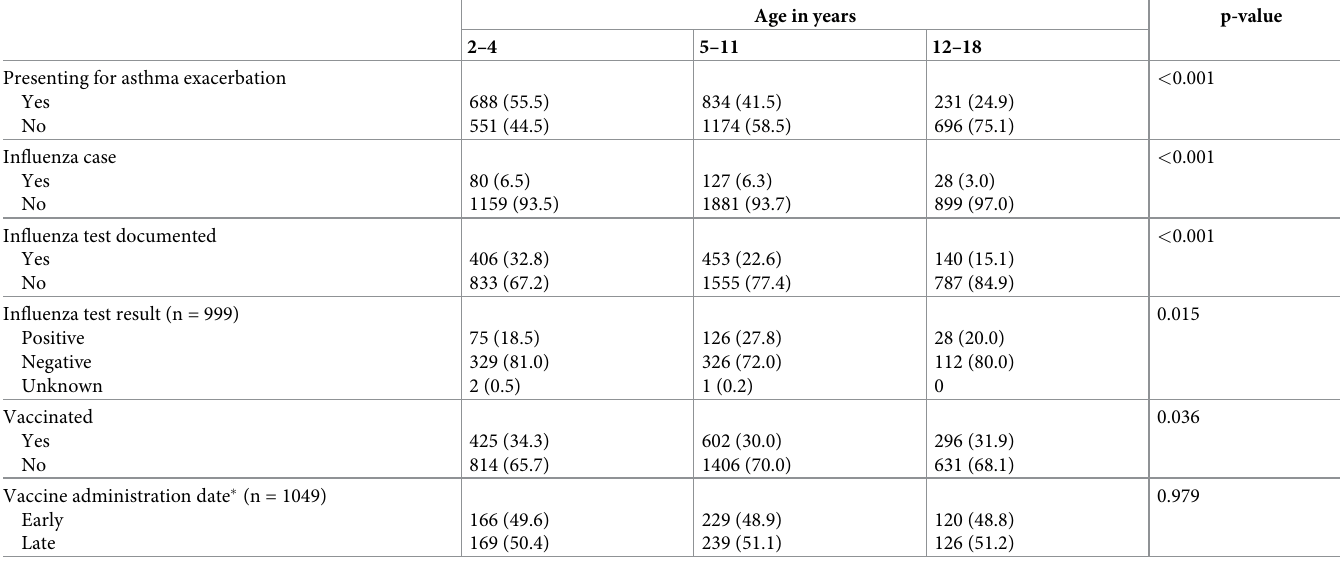
Table 3. Asthma and influenza characteristics by patient age groups.